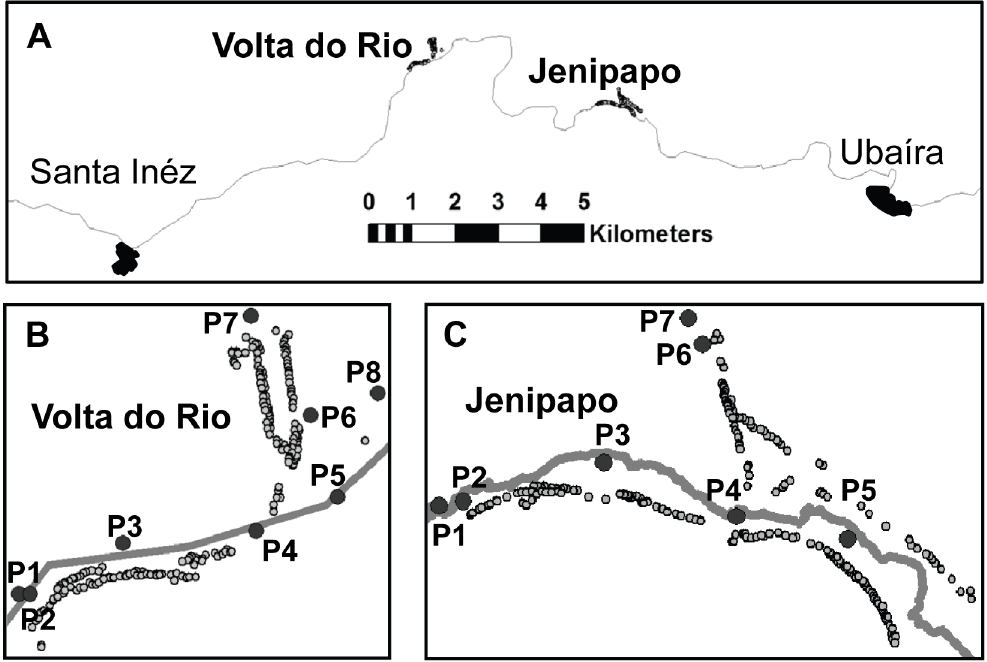
Figure 1. Study areas and water contact sites. A. Map of the Jiquiric¸a´ River Valley between the towns of Santa Ineˆs and Ubaı´ra. B. Volta do Rio. C. Jenipapo. The Jiquiric¸a´ River is represented by the solid line dividing the communities. Open circles - homes, (P) numbered water contact sites.